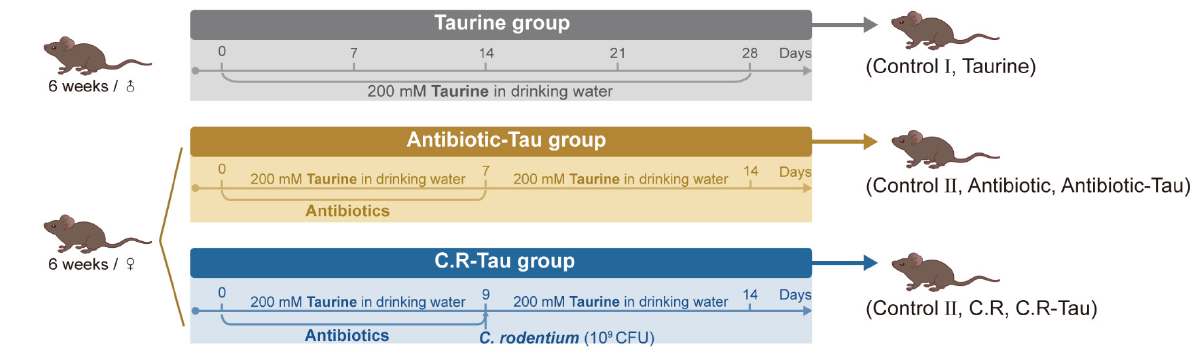
Figure 1. Animal experimental design.